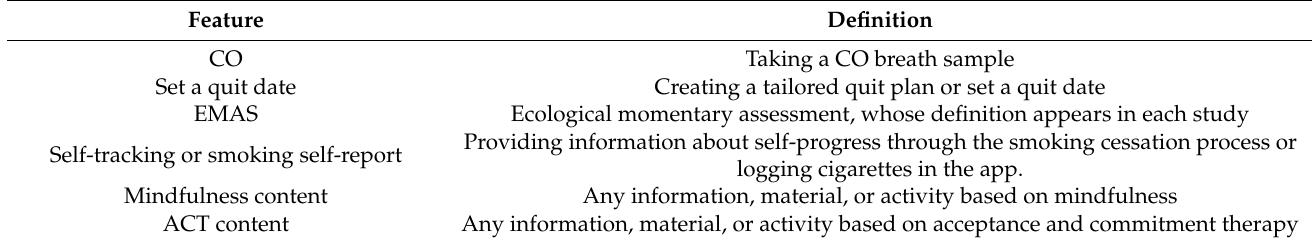
Table 3. Definitions of features of smartphone apps for smoking